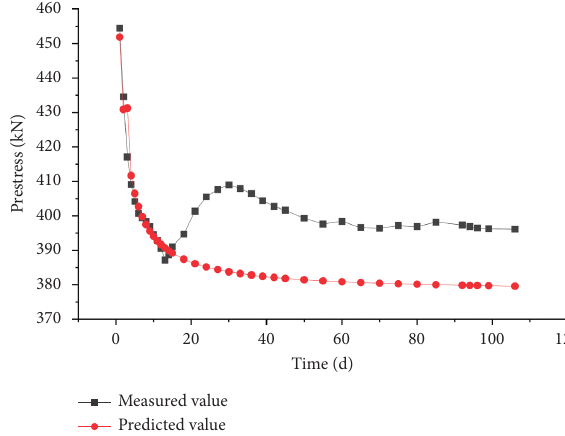
Figure 10: Comparison of measured and predicted data for the second row of 500kN anchor cables at K5